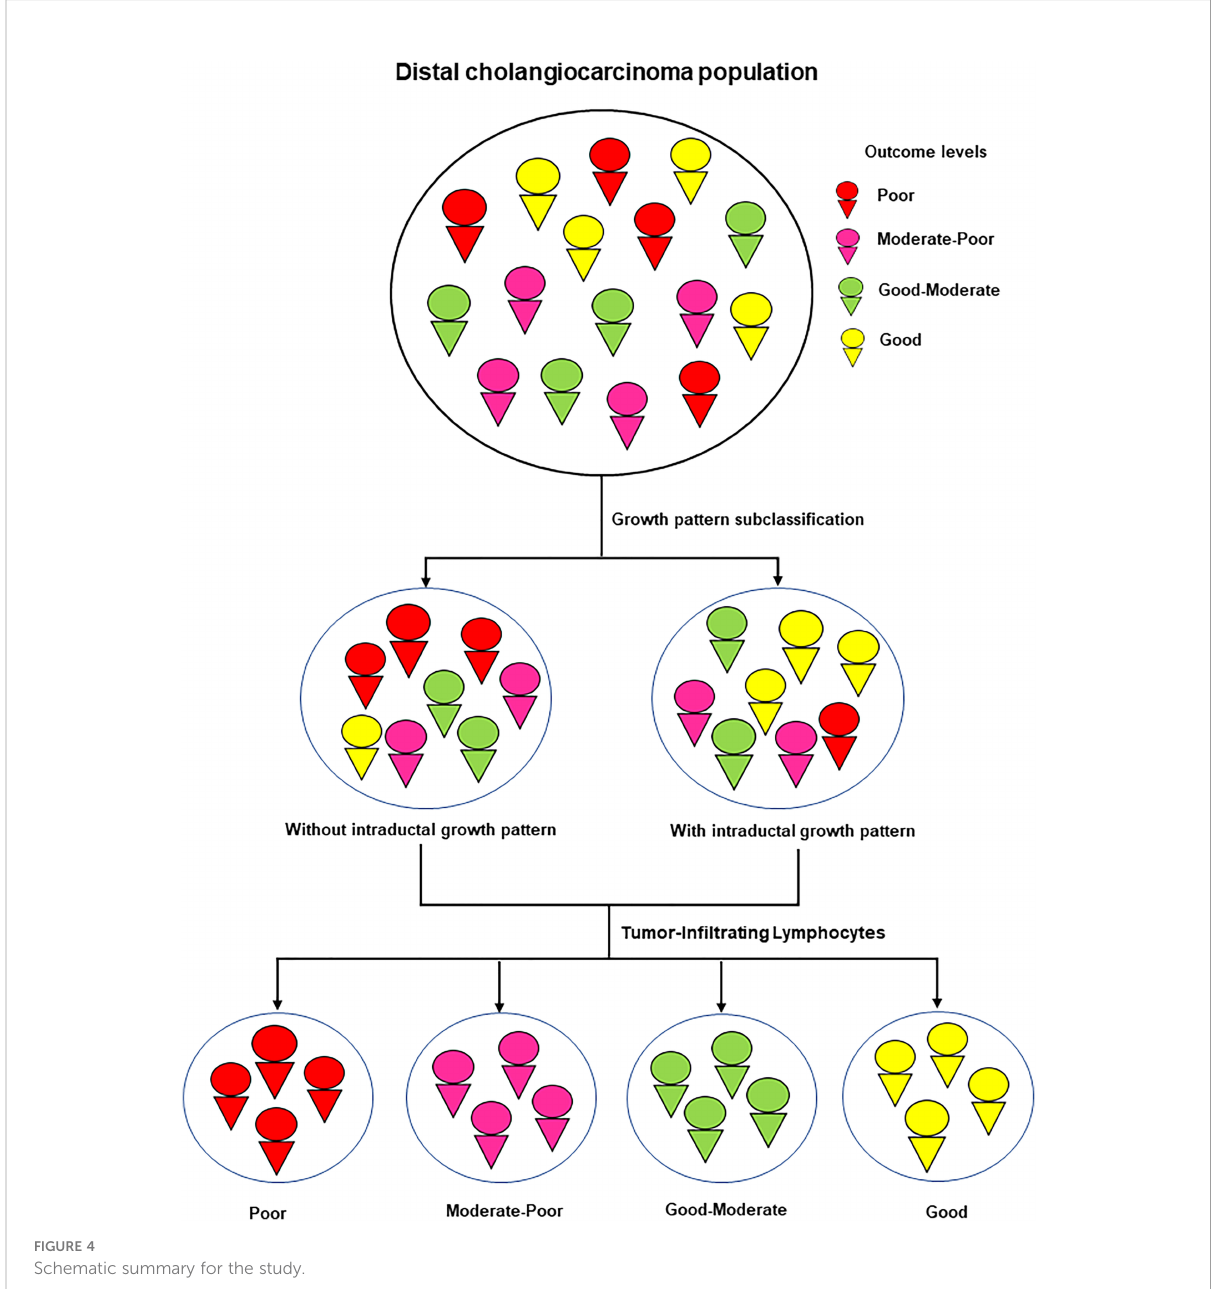
FIGURE 4 Schematic summary for the